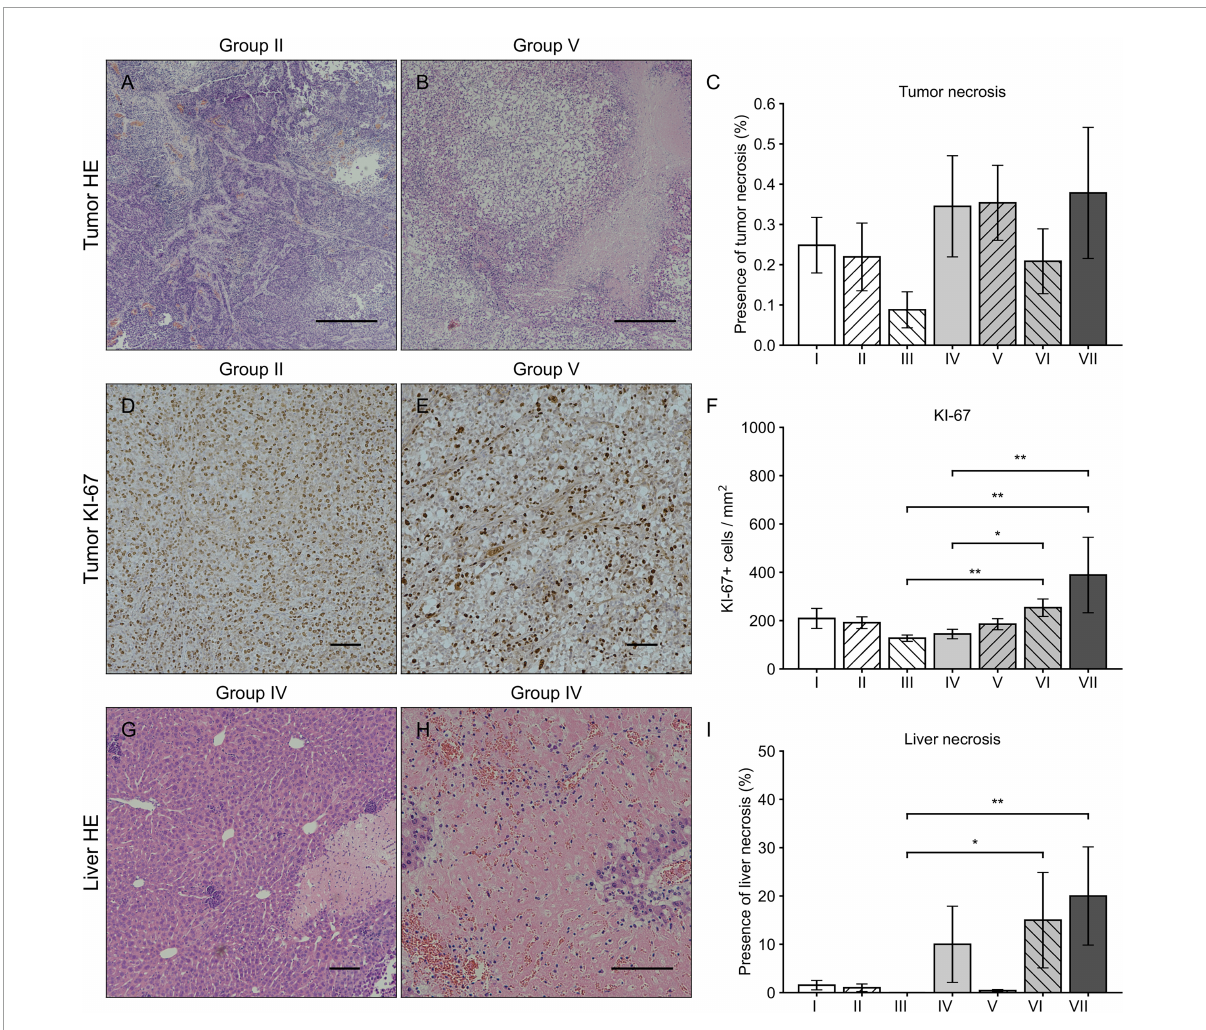
FIGURE2 HE and Ki-67 immunohistochemical stainings of tumor and liver. Tumor HE stainings from the group II (A) and VII (B) with magnification 40 × and scale bar of 500 µ m. Varying levels of tumor necrosis were observed in all groups without significant differences (C) . Tumor Ki67 stainings from the group II (D) and VII (E) with magnification 100 × and scale bar of 100 µ m. The number of Ki67 positive cells was highest in the groups VI and VII when compared to the groups III and IV (F) . Liver HE stainings from the group IV with magnification 100 × (G) and 200 × (H) with a scale bar of 100 µ m. In general, the presence of liver necrosis was higher in all groups receiving sVEGFR2 as a part of the therapy (groups IV, VI, and VII) of which the groups VI and VII showed significant differences when compared to the group III (I) . Results were considered statistically significant with values of p < 0.05* and p <